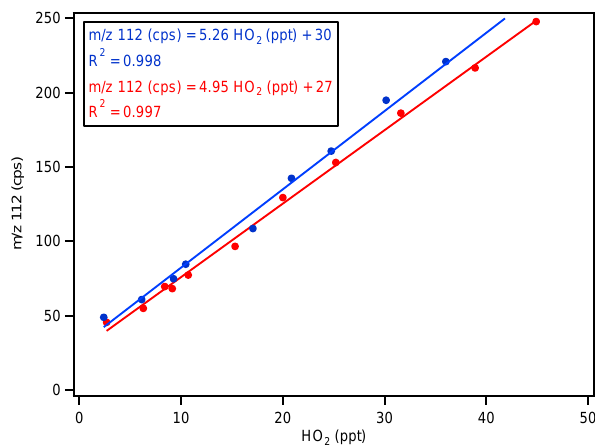
Figure 2. Laboratory HO 2 calibration curves for the 79 Br − (HO 2 ) cluster as observed at nominal m/z 112. The slopes represent the sensitivity in cpsppt − 1 . HO 2 mixing ratios are calculated us- ing Eq. (1). Two calibrations conducted on separate occasions are shown to illustrate reproducibility. The error associated with the in- dividual sensitivities is 20% which arises from the combined un- certainty of the calibration parameters (Eq. 1).